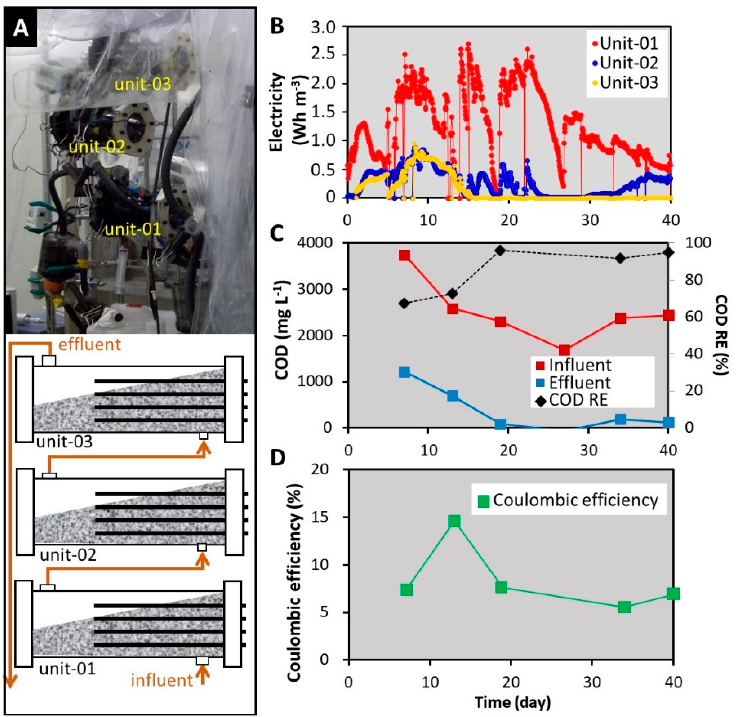
Figure 1. The configuration and photo of the ( A ) 1.5 L-microbial fuel cell (MFC), and changes in ( B ) ffi ciency during swine wastewater electricity production, ( C ) COD RE, and ( D ) Coulombic efficiency during swine wastewater treatment. electricity production, ( C ) COD RE, and ( D ) Coulombic e